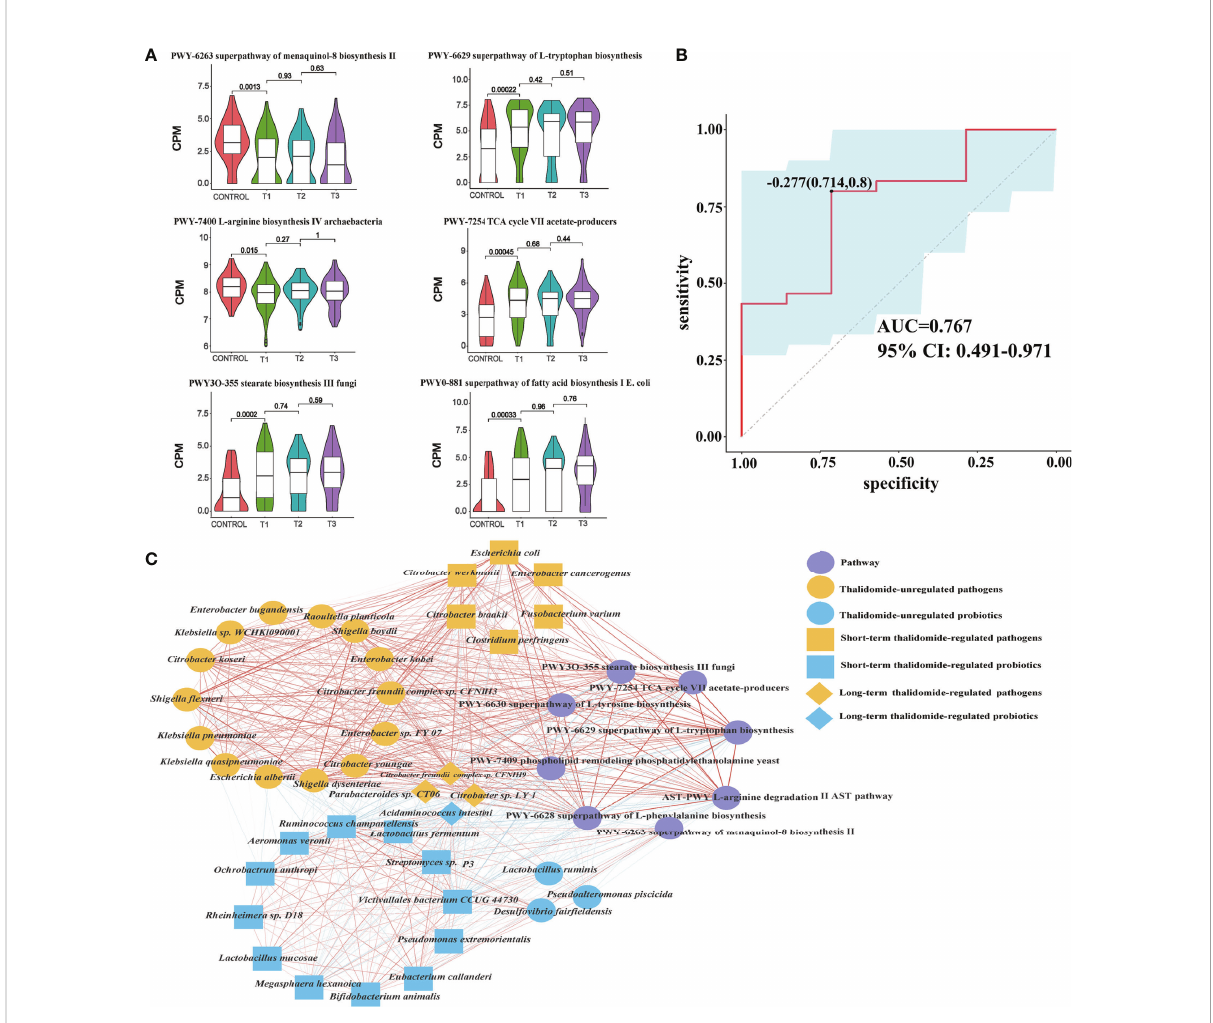
FIGURE 5 Contributional diversity offecal microbiome pathways. (A) Violin plot analysis comparing the levels of fecal pathways in control, T1, T2 and T3 groups ( P <0.05 between control and T1). (B) Receiver operating characteristic curves for fecal microbial pathways comprising samples from RAU and healthy controls. “ 0.714 ” is the sensitivity of the optimal threshold point, and “ 0.8 ” is the speci fi city. “ -0.277 ” is the socre of adaboost modle at the optimal threshold point. The blue area 95% con fi dence represents the con fi dence interval. (C) Abundance-based species-pathways correlation network enriched in RAU patients and healthy individuals. Two nodes are linked if they are related. The edge width is proportional to the correlation strength. Nodes with the different color and shapes are classi fi ed in the different effective order level with